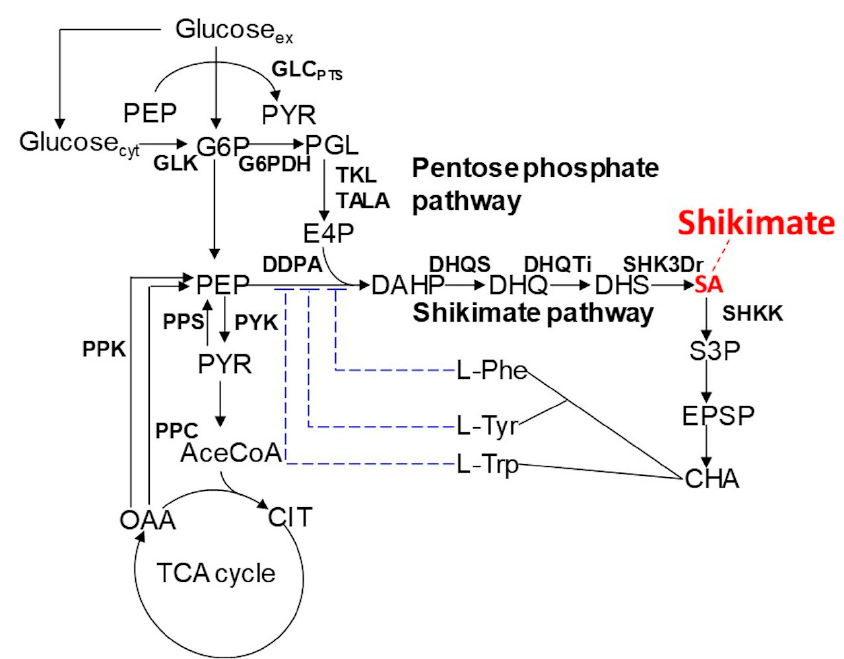
Figure 1. Schematic diagram of the metabolic pathway from glucose to shikimic acid in E. coli . Arrows indicate metabolic reactions, and hammerhead arrows indicate feedback inhibition.